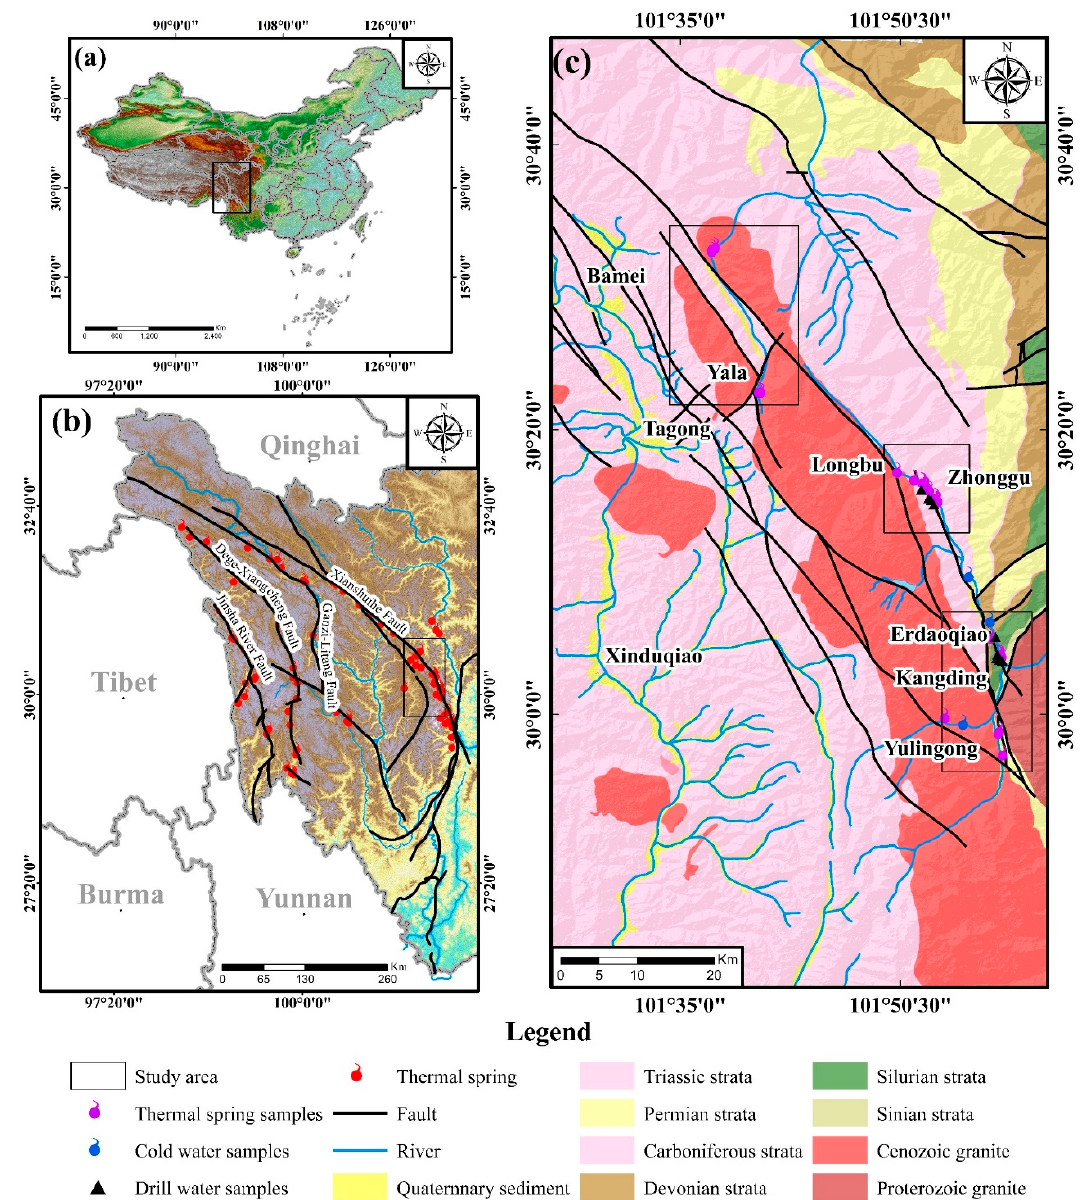
Figure 1. ( a ) Location of western Sichuan in China, ( b ) the distribution of geothermal springs in western Sichuan, and ( c ) the distribution of geothermal springs in the Xianshuihe fault zone.